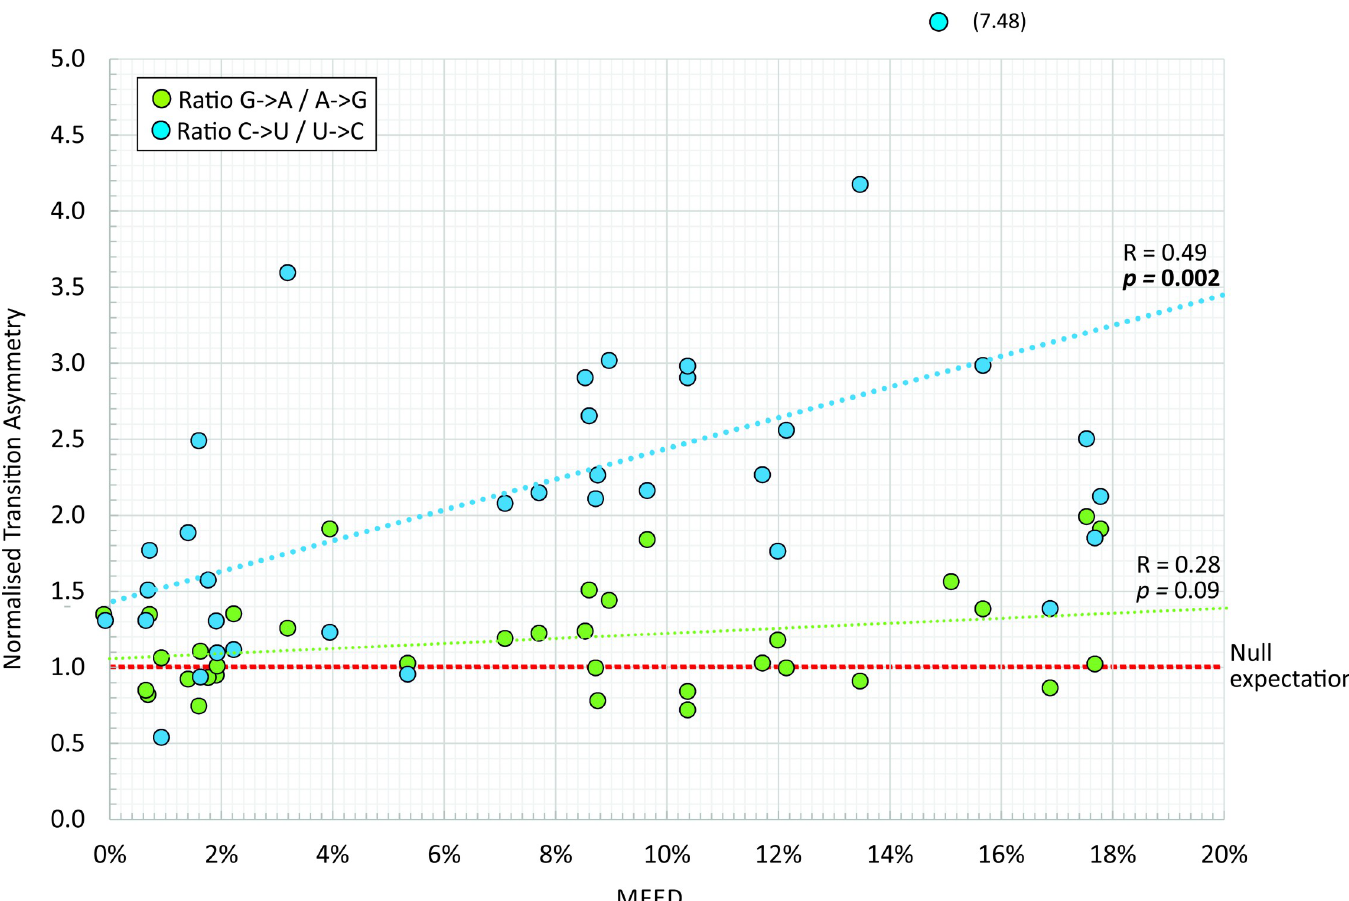
Fig 4. Association of transition asymmetries with RNA secondary structure. The association of transition asymmetry values with MFED values, indicating of the degree of genome RNA folding. Correlation values (R) and significance using linear regression for C- > U / U- > C and G- > A / A- > G asymmetries are shown.